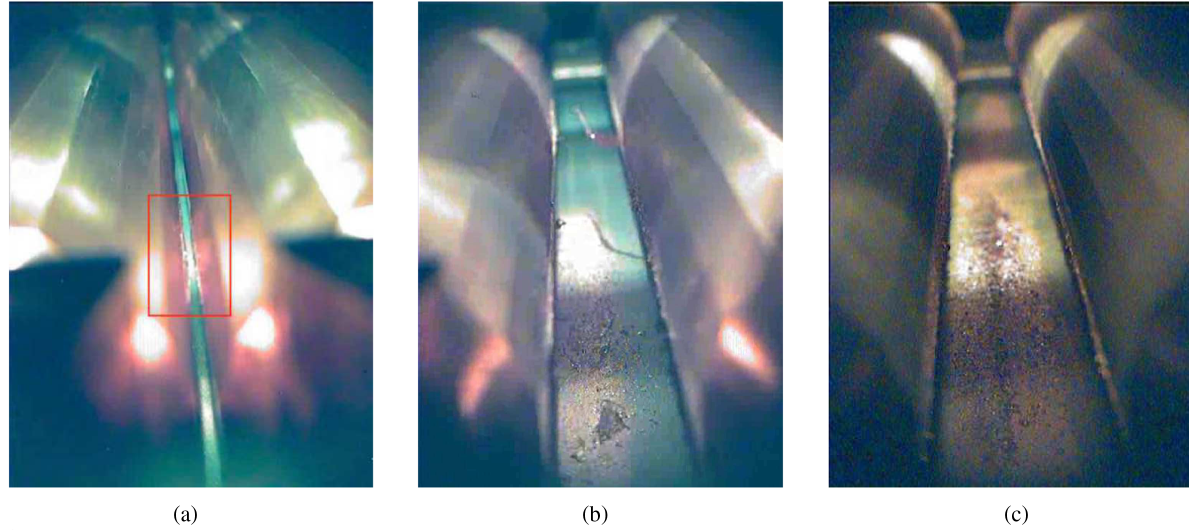
FIG. 23. Stills taken from the video stream during various instances through the HRMT-21 experiment. In each case, the beam enters the collimator from the bottom of the photograph. (a) First indication of localized damage (red box) at shot 3 (pulse 78) with 24 bunches and jaws at operational positions, (b) Debris observed after opening the jaws to parking positions after shot 5 (pulse 154) with 72 bunches, and (c) Debris observed along the full jaw length after opening the jaws to parking positions (shot 7, pulse 212, 288